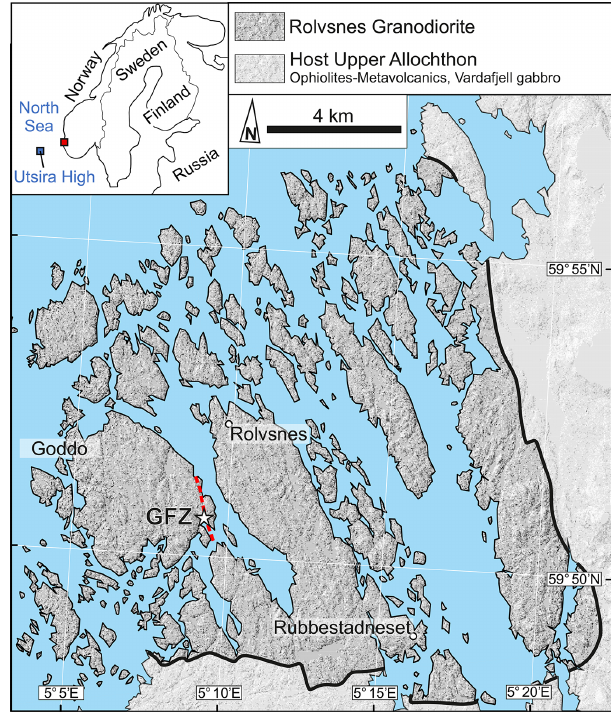
Figure 1. Simplified geological map of the part of Bømlo Island centered on the Rolvsnes granodiorite overlaying the digital ter- rain model obtained from a high-resolution (1mpxl − 1 ) lidar survey (courtesy of Norges Geologiske Undersøkelse). The inset shows the location of the study area (red square) and the location of the Utsira High within the North Sea (blue square). The trace of the exposed Goddo Fault Zone (GFZ) is indicated by the red dashed